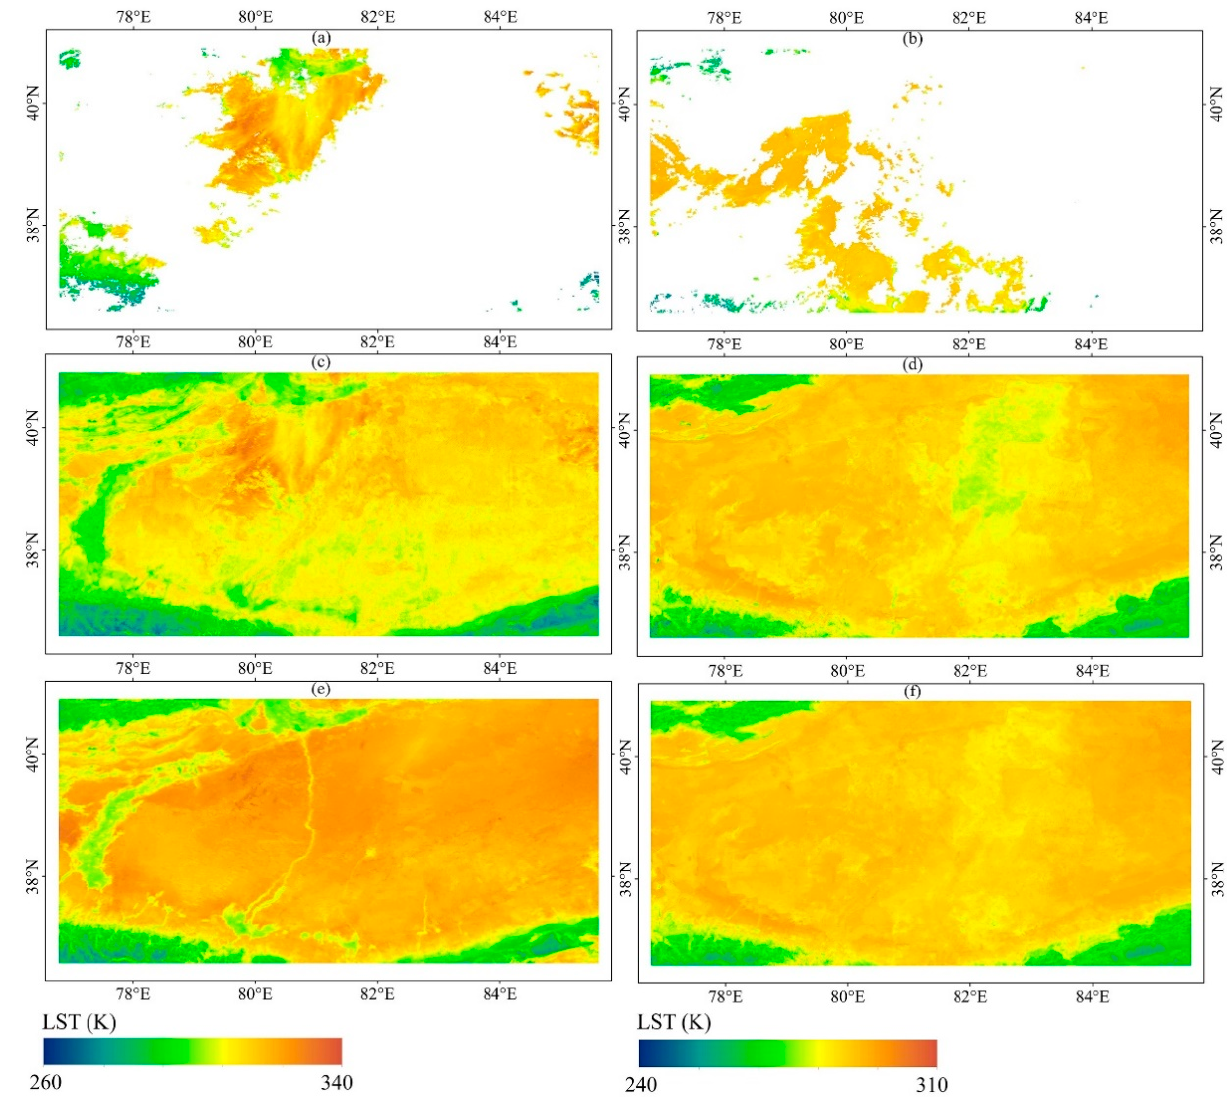
Figure 7. Comparison between ( a ) MODLSTD_Raw; ( b ) MODLSTN_Raw; ( c ) MODLSTD_Rec; ( d ) MODLSTN_Rec; ( e ) MODLSTD_SGRec, and ( f ) MODLSTN_SGRec on DOY 167 of 2018 for a subregion covered with most of bare land and small coverage of cropland, grassland and woodland.